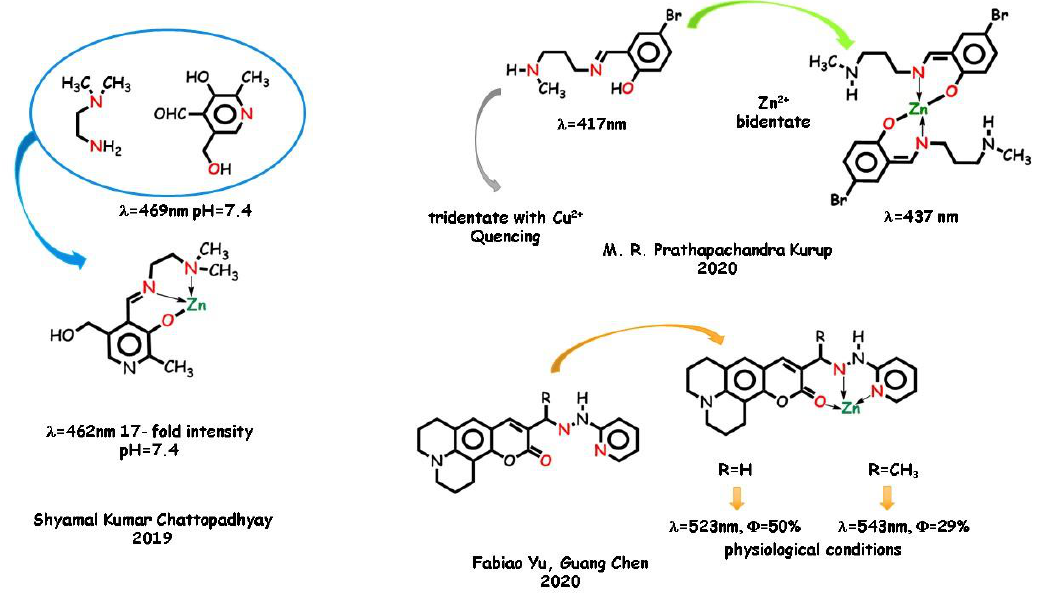
Figure 7. N , N , O pincers for sensing analysis and biological applications.